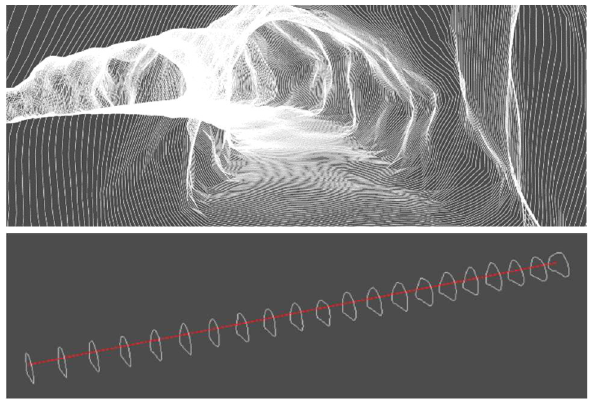
Figure 8 . Examples of cross-sections automatically extracted from the tunnel skeleton.